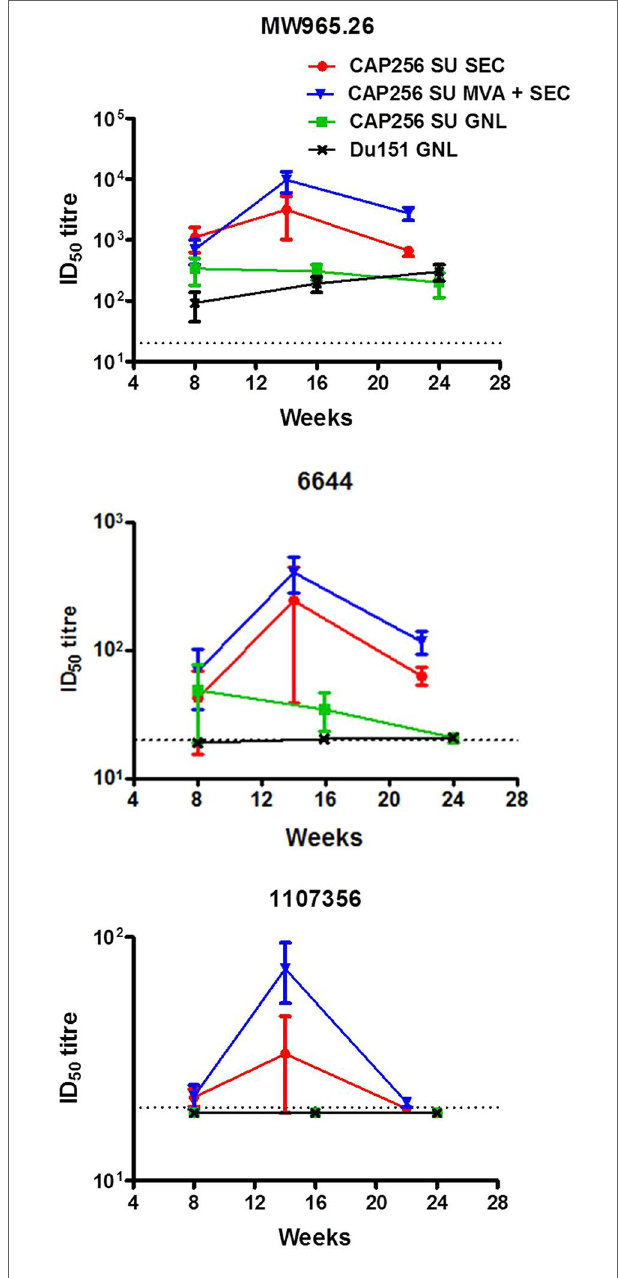
FIgUrE 3 | Temporal neutralizing antibodies elicited by the different vaccination regimens over the course of the experiment. The neutralizing antibody titres (ID 50 ) are reflected as the mean of the reciprocal dilution required to inhibit viral entry into a reporter cell line. The dotted line at 20 represents the threshold below which neutralization activity is considered